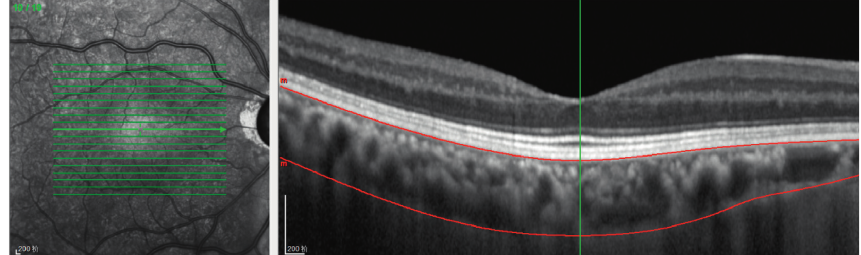
Figure 2: Optical coherence tomographic image (enhanced-depth imaging mode) for the measurement of the macular choroidal Table 2: Comparisons of macular choroidal thickness by EDI-OCT in three groups. Regions